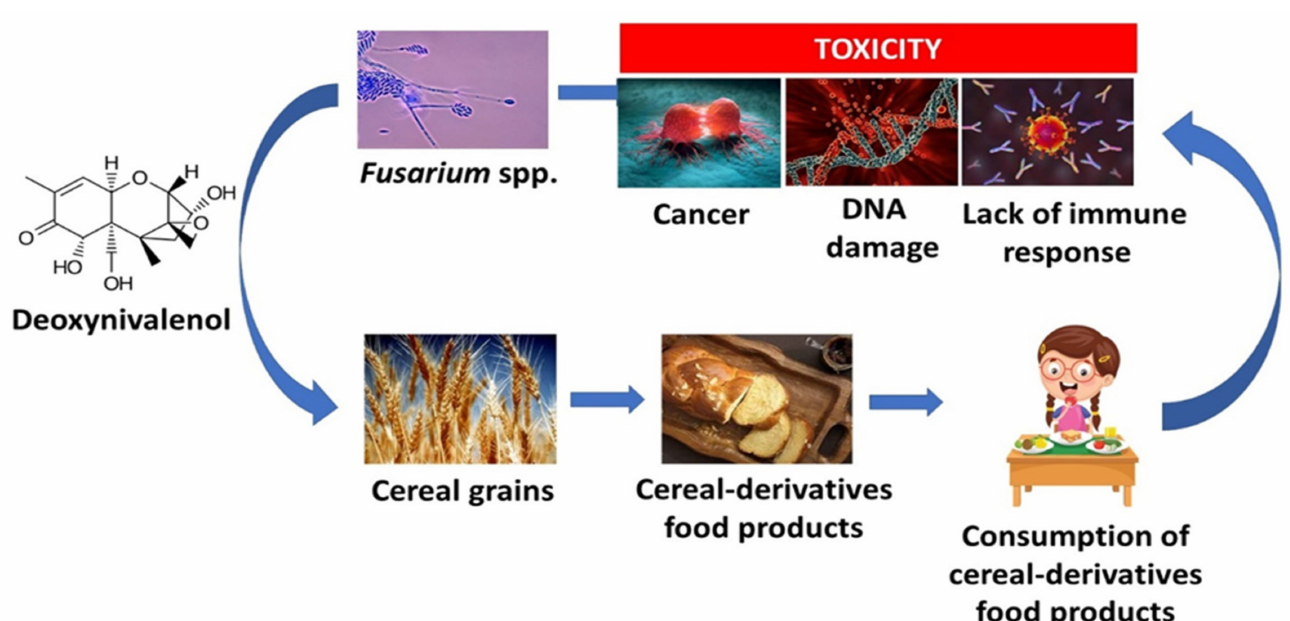
Figure 4. Humans’ exposure to mycotoxins through cereal-derived products can lead to cancer, DNA damage, and a lack of immune